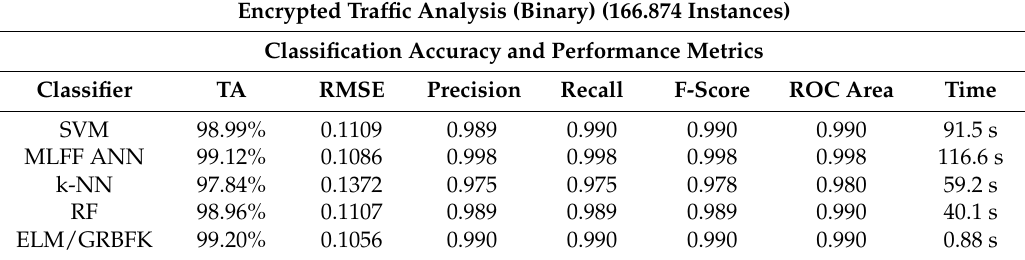
Table 4. Comparison between algorithms.